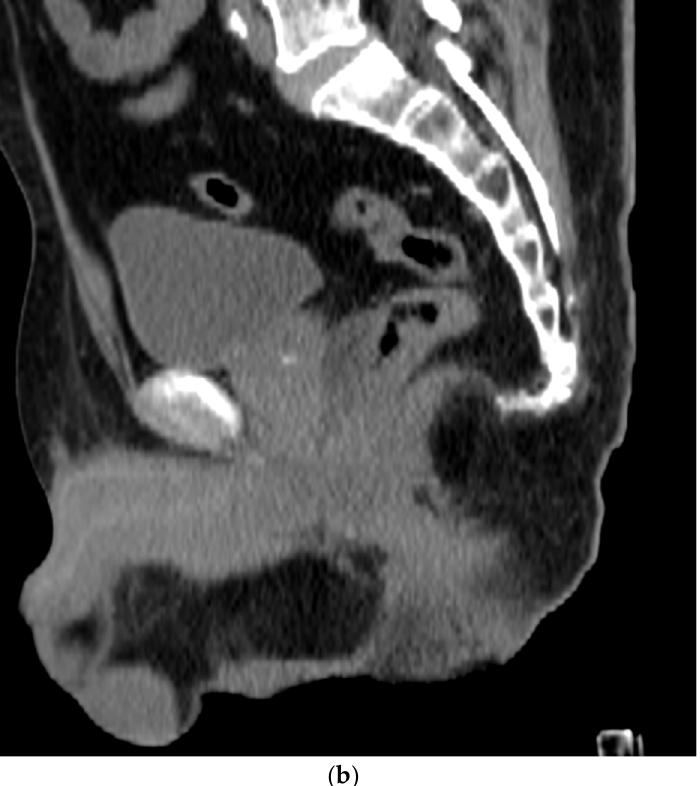
Figure 4. ( a ). Axial view after the injection of SpaceOAR shows 1.1 cm of distance added between the rectum and the prostate at the level of the mid-gland. Due to the lack of iodine, the hydrogel is difficult to visualize and is seen as a hypodense soft tissue density. ( b ) Sagittal CT shows a soft tissue hypodense SpaceOAR between the rectum and prostate.